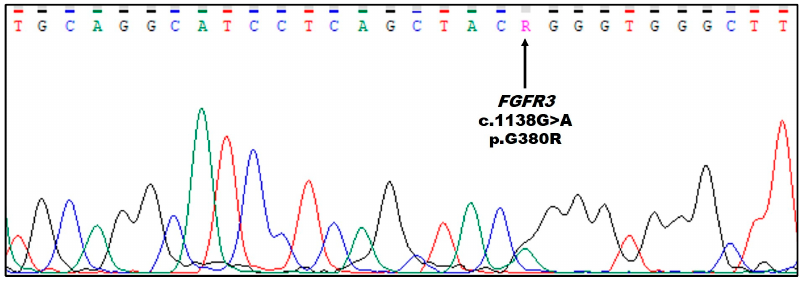
Figure 1. Sequence chromatogram showing the heterozygous FGFR3 c.1138G>A (p.G380R) mutation in the pediatric